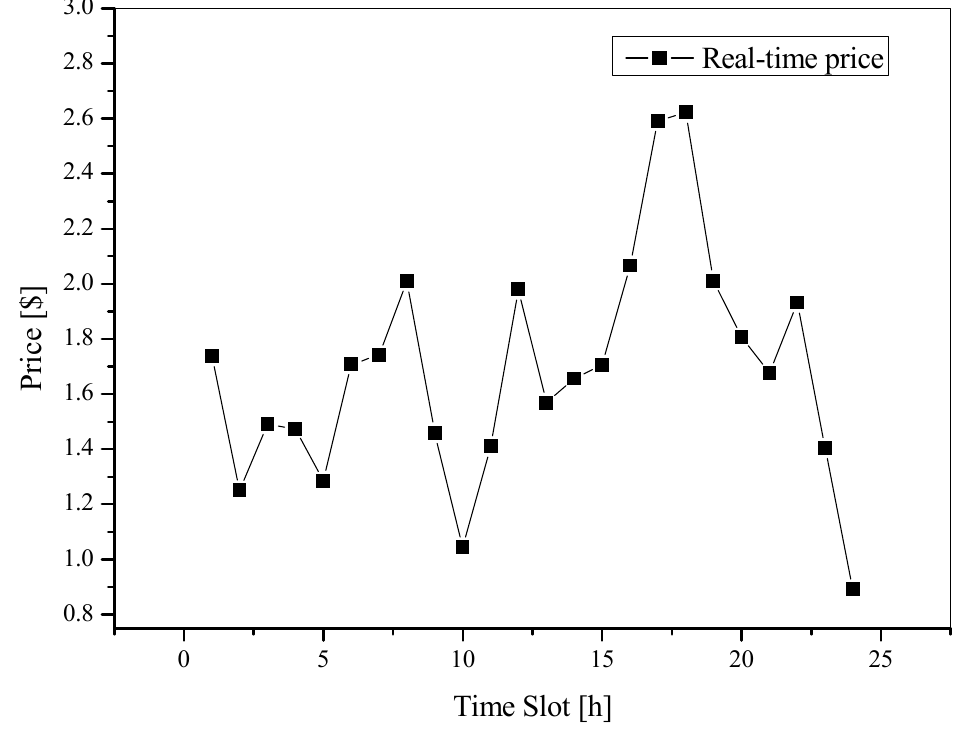
Figure 2. Real-time price of a day.